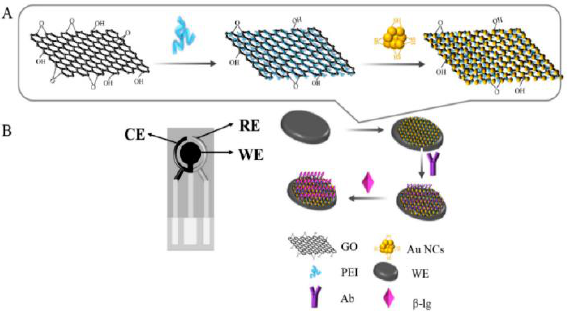
Figure 1. Immunosensor assembly strategy: ( A ) nanocomposite synthesis, modifying rGO with PEI and AuNCs (PEI-rGO-AuNCs); ( B ) SPCE modification, Ab immobilization, and β -LB detection, reprinted from [72]. CE = counter electrode; RE = counter electrode; and WE = working electrode.